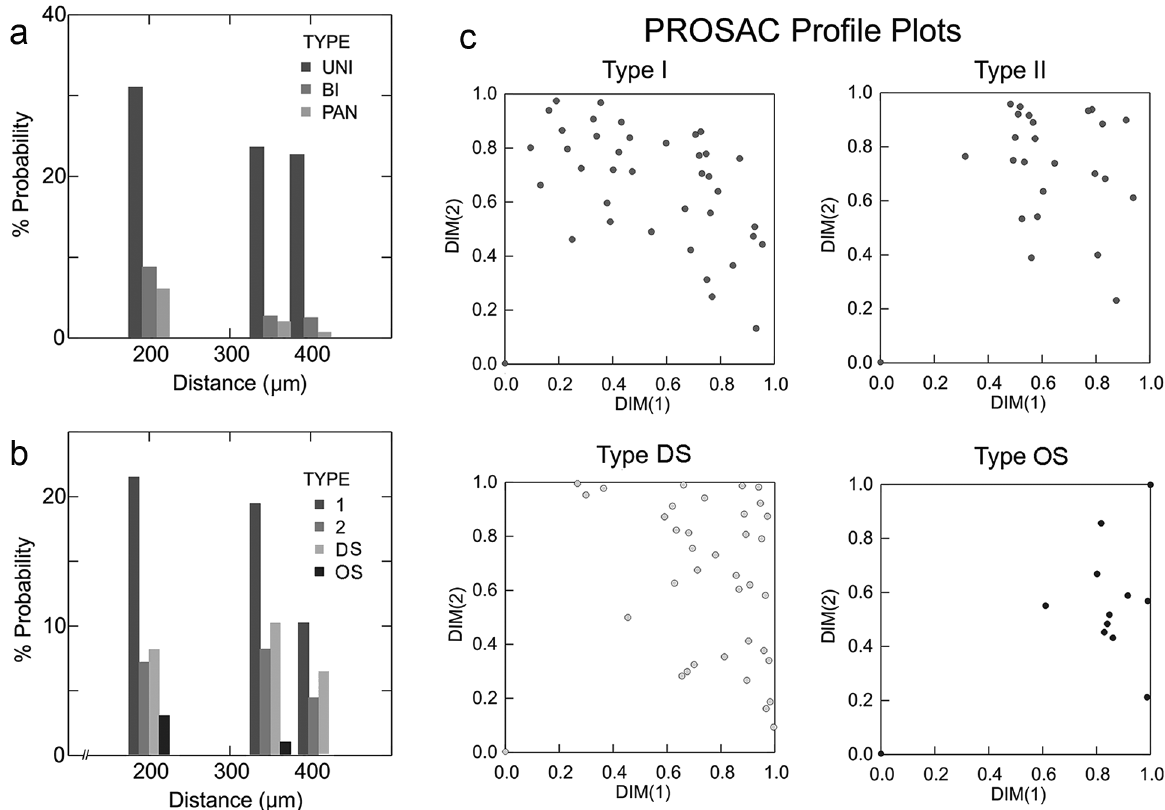
Figure 5. Clustering analysis of direction selectivity and cell type in the surface dimension of area MT. (a) Clustering of direction selectivity evaluated using next neighbor probability (PROSAC). The clustering probability is plotted as a function of distance on the surface dimension. Unidirectional sites showed significant clustering at around 200 µm (note the decay > 300 µm). (b) Clustering of cell type evaluated using next neighbor probability (PROSAC). Type I cells were significantly clustered at around 300 µm (note the marked decay on probability of occurrence > 400 µm). Type OS cells showed a trend for clustering at around 200 µm, but the result did not reach statistical significance. (c) PROSAC profile plots for each of the four cell